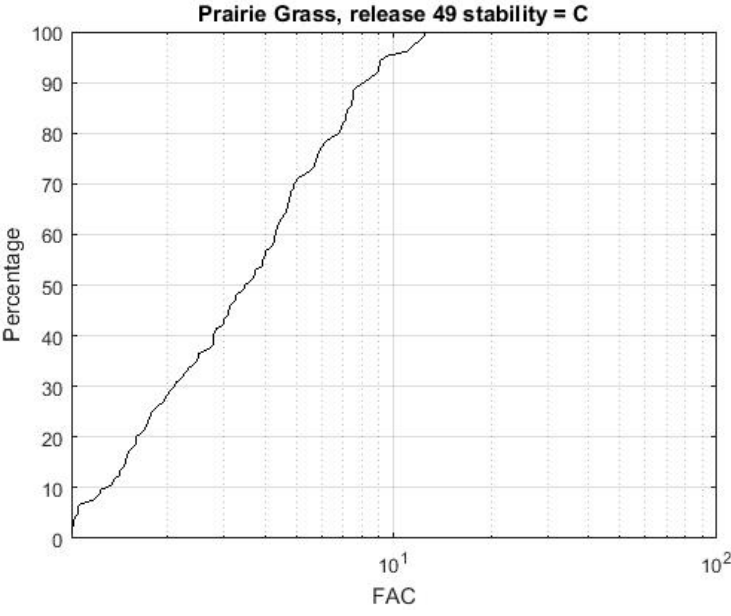
Figure 5. Cumulative Factor (CF) plot comparing UDM predictions against observed concentrations for release 49 of Prairie Grass.